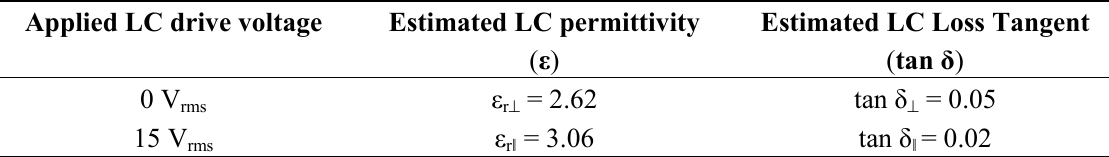
Table 5. Preliminary estimation of the dielectric properties extreme values for the LC Merck MDA-98-1602.